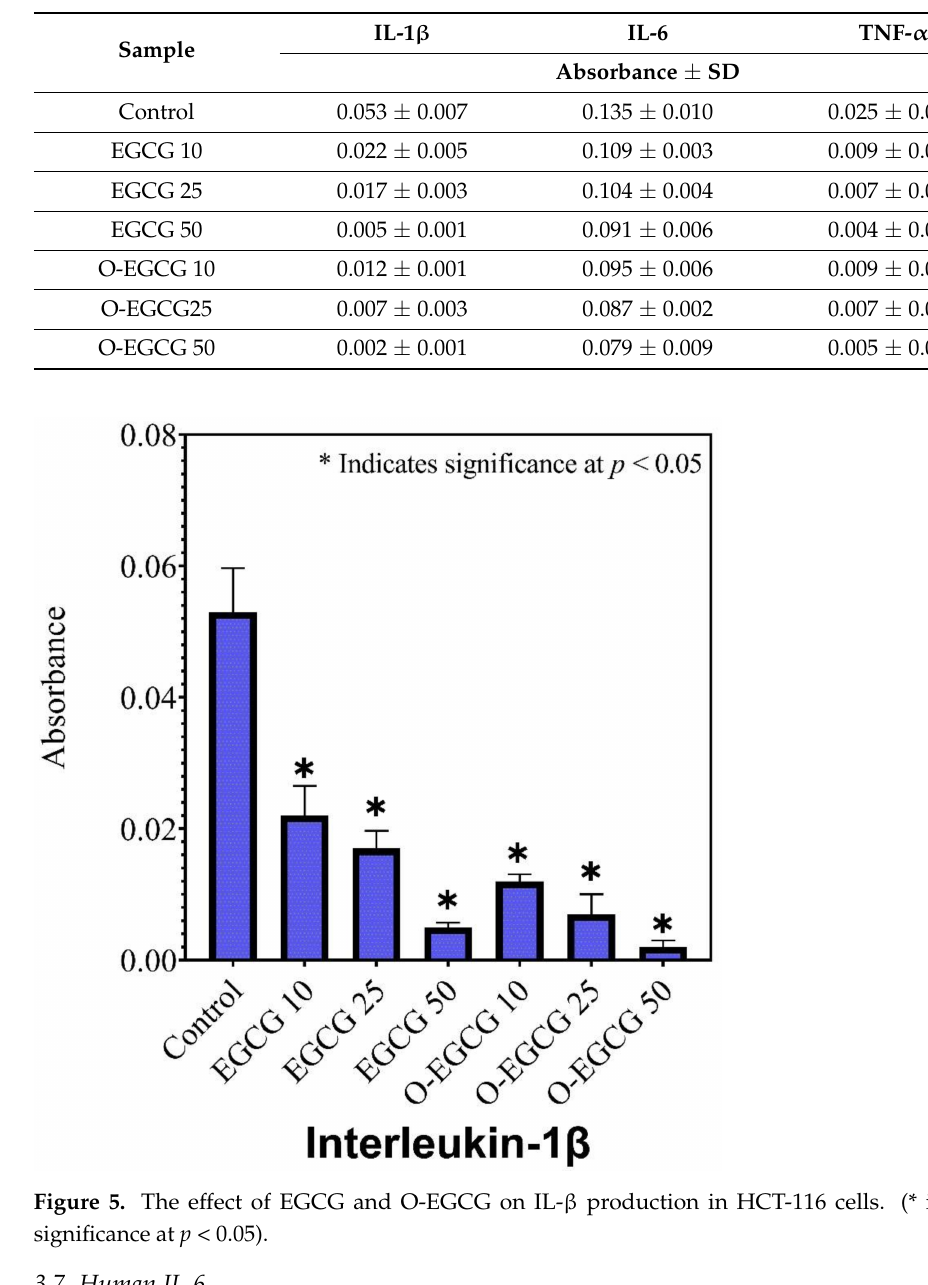
Table 4. Effect of EGCG and O-EGCG on inflammatory cytokines (IL-6, IL-1 β , TNF- α ).